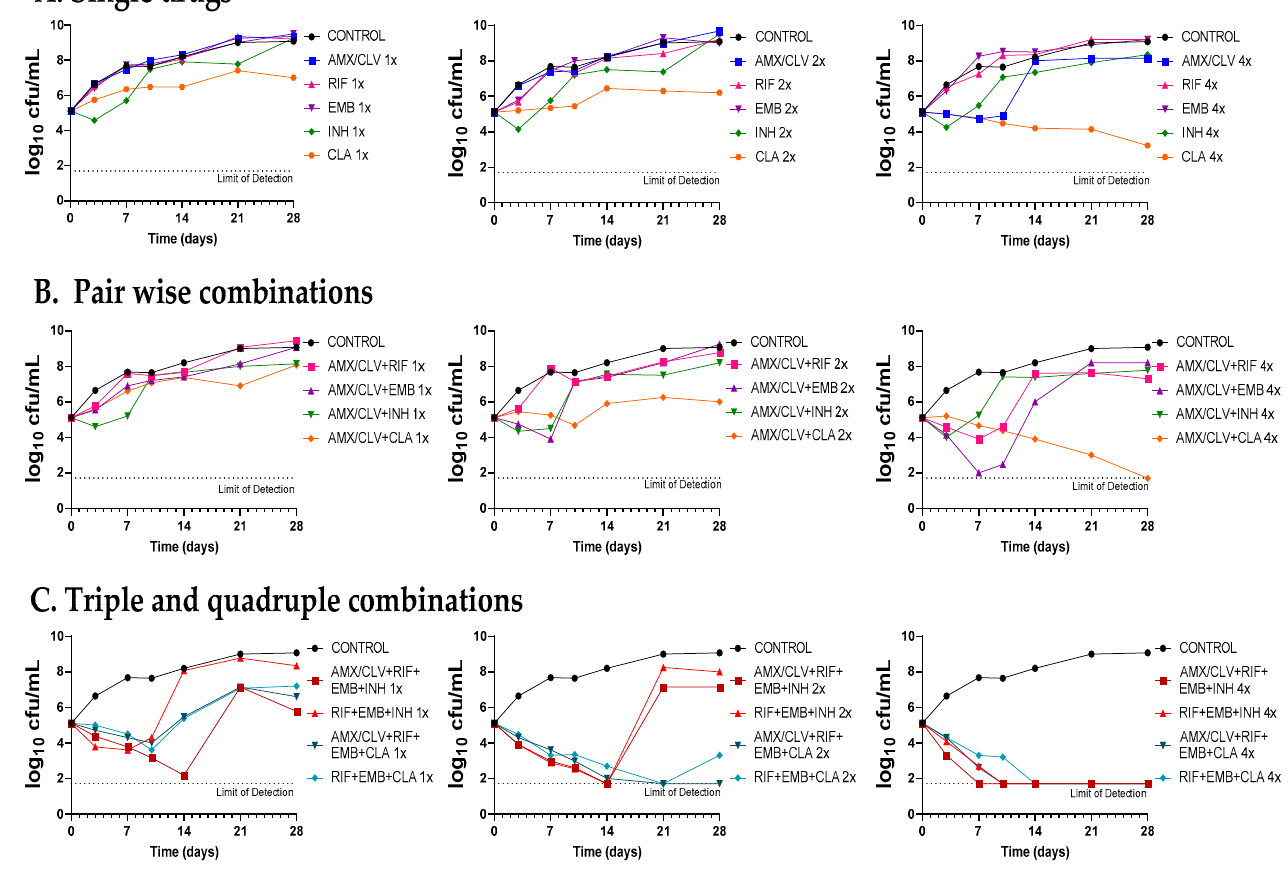
Figure 4. Time-kill assays of amoxicillin–clavulanate in combination with standard therapies against Mkn ATCC 12478. ( A ) Single drugs. ( B ) Pairwise combinations of amoxicillin–clavulanate with either rifampicin, ethambutol, isoniazid or clarithromycin. ( C ) Standard triple therapies against Mkn and quadruple combinations including amoxicillin–clavulanate. Time-kill assays were performed in Middlebrook 7H9 broth plus ADC. MIC values used were: AMX: 8 mg/L; RIF: 0.125 mg/L; EMB: 4 mg/L; CLA: 0.25 mg/L and INH: 8 mg/L. Clavulanate was added at a fixed dose of 4 mg/L. A drug-free positive control culture was included (CONTROL). Data represents one experiment of at least two independent experiments performed in duplicate. AMX/CLV: amoxicillin–clavulanate; RIF: rifampicin, EMB: ethambutol, INH: isoniazid, CLA: clarithromycin.